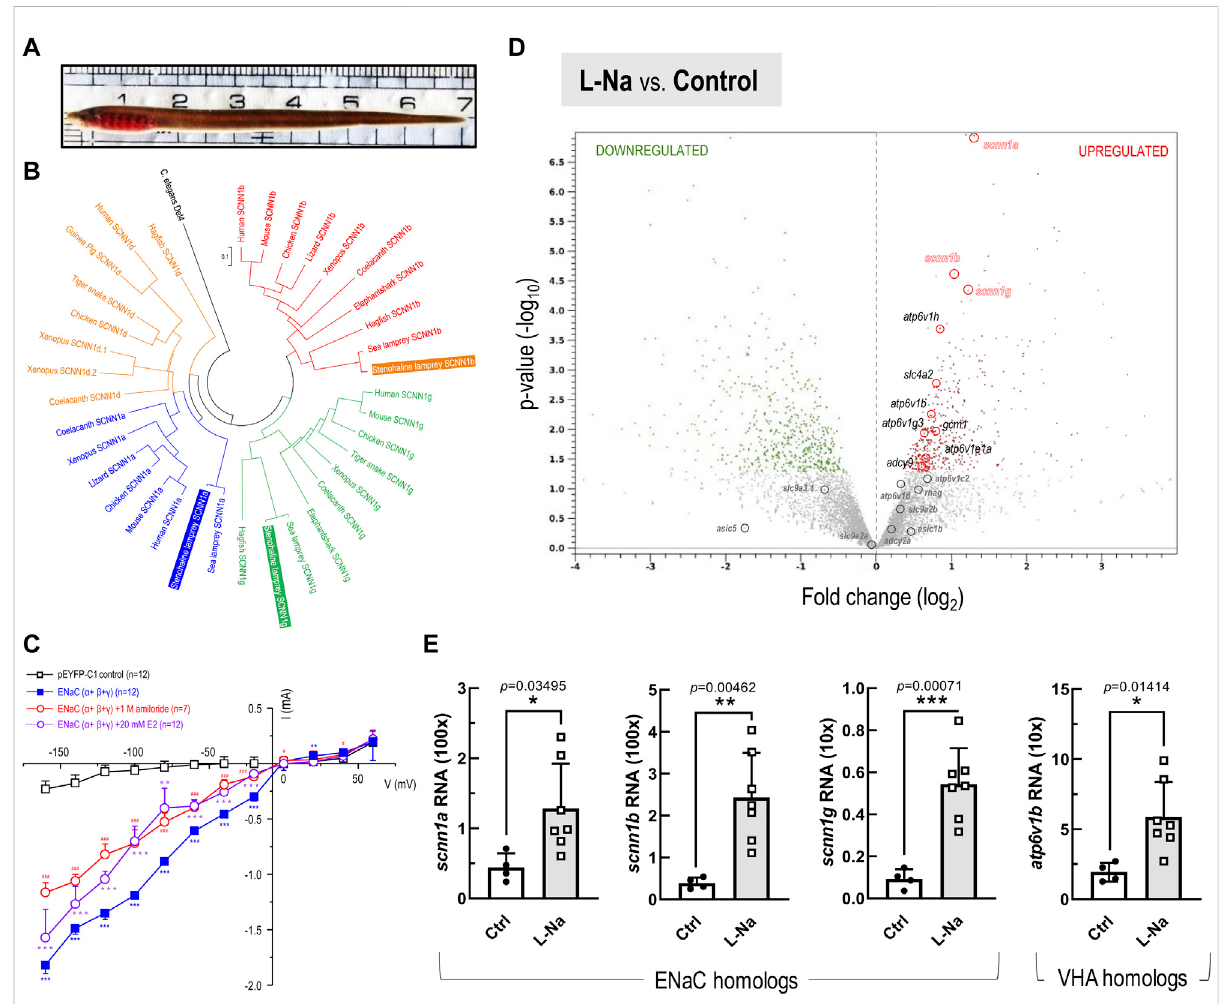
FIGURE 2 PhylogeneticwithfunctionalanalysisofepithelialNa + channel(ENaC),andRNA-Seqtranscriptomepro fi ling-basedtranscriptexpressionsinthe stenohaline lamprey ( Lethenteron reissneri ). ( A) , Represented morphology of stenohaline lamprey applied in this study. (B) , Phylogenetic analysis of ENaCsubtypesinvariousorganisms.ENaChomologscouldbesub-dividedintofourclusters,andboththestenohalinelampreyandthesealamprey ( Petromyzon marinus ) ENaC consists of alpha ( scnn1a ), beta ( scnn1b ), and gamma ( scnn1g ) subunits. The scnn1d gene characterized in other vertebrates waslostinboththestenohaline-andsea-lampreys.The degenerin/epithelialNa + channel in Caenorhabditis elegans wasselected asthe outgroup gene. (C) , Current-voltage relationships in the HEK293 cells expressing stenohaline lamprey ENaC ( α + β + γ ) and the control cells transfectedthepEYFP-C1 plasmid. Data areexpressedas mean± SE. Asterisk (*), hashtag (#),and at-sign ( p )indicate signi fi cantdifferences between groups of ENaC( α + β + γ )-expressing cells, ENaC ( α + β + γ )-expressing cells+1 M amiloride, and ENaC( α + β + γ )-expressing cells+20 mM estrogen (E2), respectively,comparedwiththegroupofexpressionvector(pEYP-C1)-injectedcells(Student ’ st-test). p < 0.05(*or#or pp ), p < 0.01(**or##or pp ), and p < 0.001 (***or ### or ppp ) indicate signi fi cant differences treatment conditions and control group. (D) , The volcano plot shows fold changes (represented as log 2 ) versus p -values (represented as -log 10 ) for the analyzed transcriptome pro fi ling in the gills between low-Na + (0.01 mM, L-Na) and control freshwater (1.05 mM, Ctrl) groups ( n = 4 in each group). Based on differential expression analysis, the red and green dots, respectively, indicate transcripts with signi fi cantly upregulated and downregulated expression ( p -value < 0.05) in the stenohaline lamprey gill under low-Na + conditionscomparedtothecontrolfreshwater.Meanwhile,greydotsmarkthetranscriptswith p -value > 0.05. (E) ,mRNAexpressionlevelsof scnn1a (ENaC α ), scnn1b (ENaC β ), scnn1g (ENaC γ ),and atp6v1b (VHA)inthegillsofthestenohalinelampreyestimatedbyquantitativereal-timePCR.Values were normalized by ribosomal protein L18 ( rpl18 ). Data are expressed as mean ± SE. Asterisk indicates signi fi cant difference of p < 0.05 (*), p < 0.01 (**), or p < 0.001 (***) between low-Na + condition and the control FW group (Student ’ s t